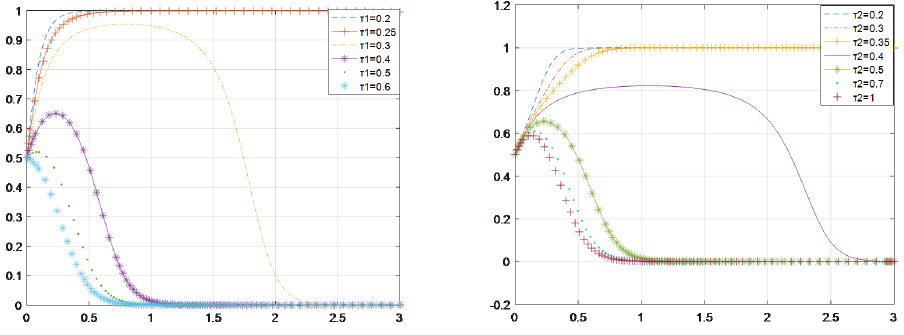
Fig. 4 The influence of τ on the shared strategy of enterprise.